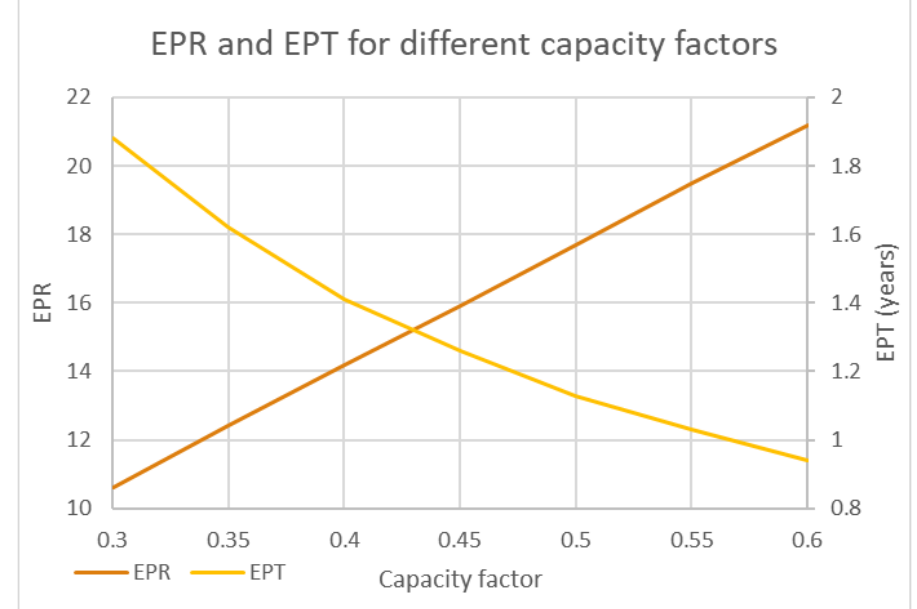
Figure 6. Changes in the EPR and EPT for different capacity factors.